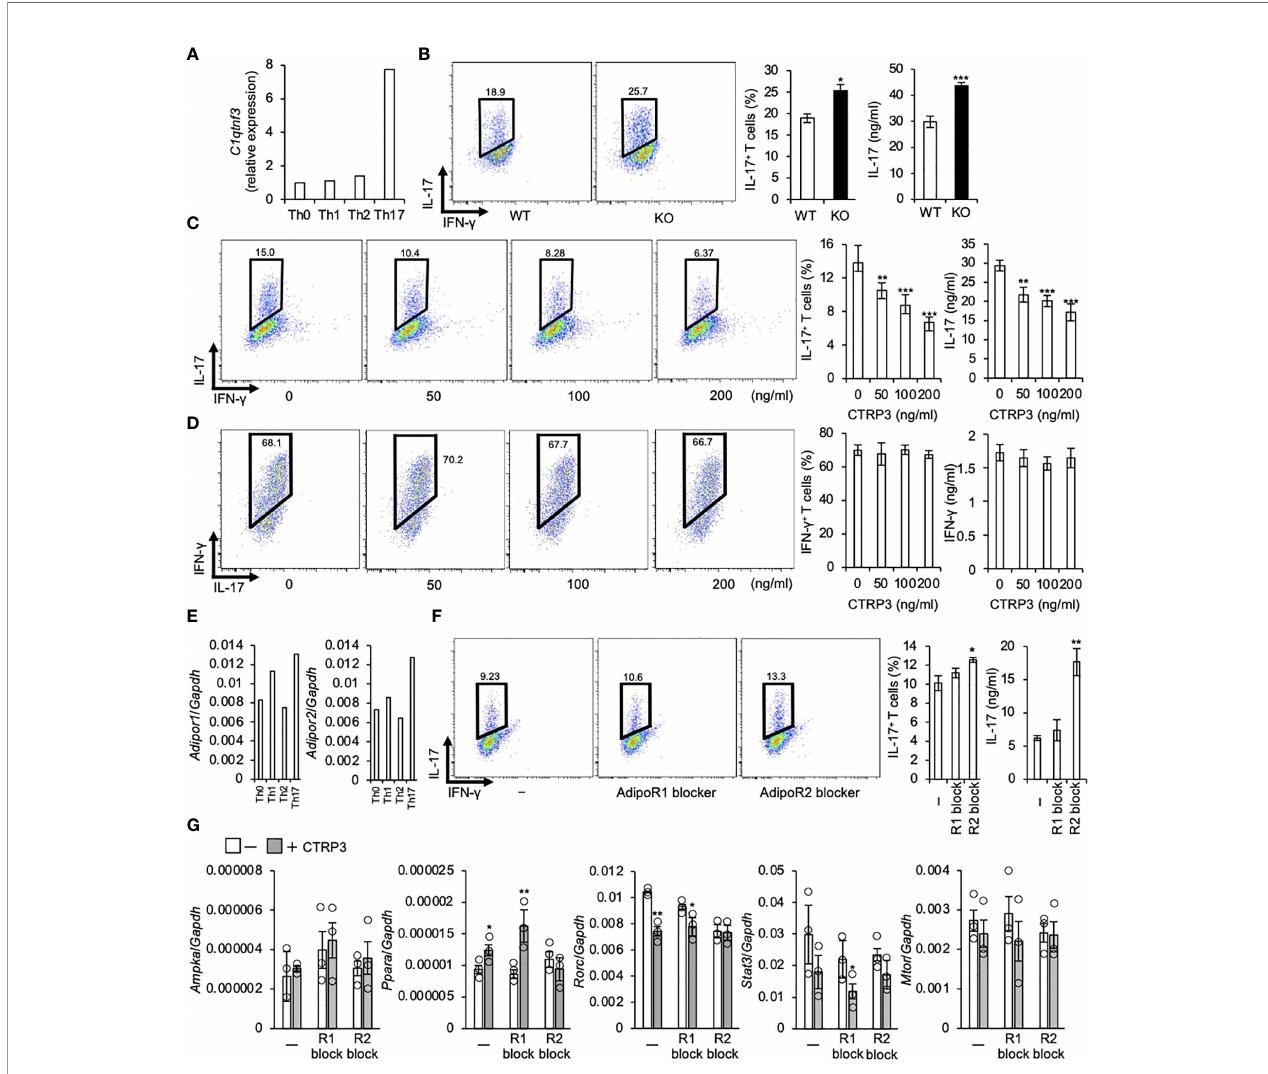
FIGURE 1 | CTRP3 inhibits the differentiation of Th17 cells in an autocrine manner. (A) The relative expression of C1qtnf3 mRNA in different Th subsets was determined by real-time PCR, and the expression levels are shown relative to that of Th0 cells. Th0, Th1, Th2 and Th17 cells were prepared as described in the Materials and Methods section. (B) WT or C1qtnf3 – / – (KO) naïve CD4 + T cells were cultured under Th17-polarizing conditions for 4 days (n = 4 each). Intracellular IL-17 expression was estimated by fl ow cytometry after PMA/ionomycin stimulation. The numbers in each panel indicates percentage of IL-17 + CD4 + T cells in total CD4 + T cells (2 left panels). The content of IL-17 + CD4 + T cells in total CD4 + T cells (%) (center), and IL-17 concentrations (ng/ml) in culture supernatant determined by ELISA (right). Average and SEM are shown. * p < 0.05, *** p < 0.001. Student ’ s t -test. (C) C1qtnf3 – / – naïve CD4 + T cells were cultured under Th17-polarizing conditions in the absence or presence of recombinant CTRP3 (50, 100 and 200 ng/ml) for 4 days (n = 4 wells each). Intracellular IL-17 expression was estimated by fl ow cytometry after PMA/ionomycin stimulation. The number in each panel indicates the percentage of IL-17 + CD4 + T cells (left), and the proportion of IL-17 + CD4 + T cells is shown in the center panel. IL-17 concentration in the culture supernatant was determined by ELISA (right). Average and SEM are shown. ** p < 0.01, *** p < 0.001. Student ’ s t -test. (D) C1qtnf3 – / – naïve CD4 + T cells were cultured under Th1-polarizing conditions for 3 days (n = 4 wells each). Intracellular IFN- g expression was evaluated by fl ow cytometry after PMA/ionomycin stimulation. The number in each panel indicates the percentage of IFN- g + CD4 + T cells in total CD4 T cells (left). The population of IFN- g + CD4 + T cells (center). IFN- g concentration in the culture supernatant determined by ELISA (right). Average and SEM are shown. Student ’ s t -test. (E) The expression of Adipor1 and Adipor2 mRNA in different Th subsets was determined by real-time PCR and relative expression levels to that in Th0 cells are shown. (F) C1qtnf3 – / – naïve CD4 + T cells were cultured with recombinant CTRP3 (200 ng/ml) under Th17-polarizing conditions in the absence (-) or presence of AdipoR1 blocker (R1 block, 10 m g/ml) or AdipoR2 blocker (R2 block, 10 m g/ml) for 4 days (n = 4 each). Intracellular IL-17 expression was evaluated by fl ow cytometry after PMA/ionomycin stimulation. The number in each panel indicates percentage of IL-17 + CD4 + T cells (left). The IL-17 + CD4 + T cell content (center). IL-17 concentration in the culture supernatant determined by ELISA (right). Average and SEM are shown. * p < 0.05, ** p < 0.01. Student ’ s t -test. (G) The effect of AdipoR1 blocker and AdipoR2 blocker on the regulatory effects of CTRP3 on Th17 cell gene expression was examined. In vitro differentiated C1qtnf3 – / – Th17 cells (1 x 10 5 cells in 200 m l/96 well) were treated with CTRP3 (200 ng/ml) in the presence or absence of AdipoR1 blocker (10 m g/ml, R1 block) or AdipoR2 blocker (10 m g/ml, R2 block), and the expression of Ampka , Ppara , Rorc , Stat3 and Mtor mRNA was determined by real-time PCR. The relative expression levels to that of Gapdh are shown. These data are the average from three independent experiments. Average and SEM are shown. * p < 0.05, ** p < 0.01. Student ’ s t -test. All data were reproduced in another independent experiment with similar